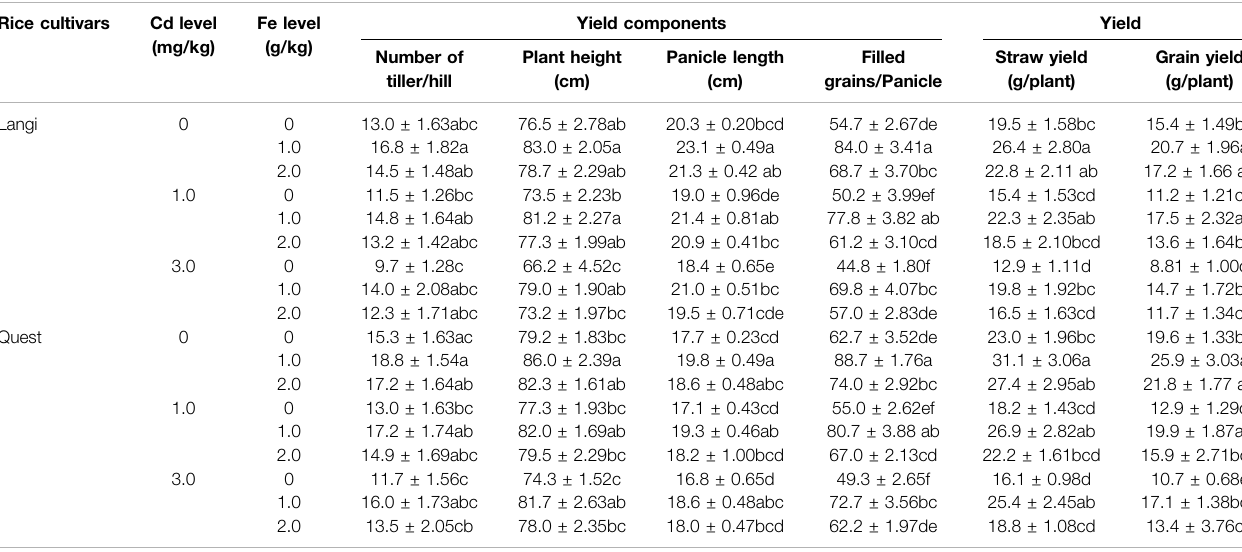
TABLE 5 | Effect of Fe and Cd on yield components and yield of rice cultivar. Rice